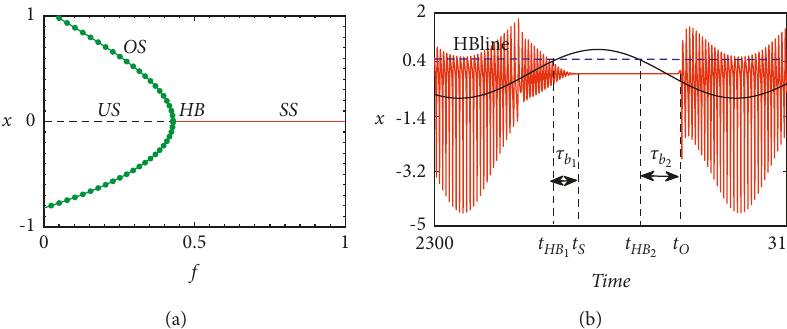
Figure 5: (a) One-parameter bifurcation diagram as a function of amplitude of external forcing f . Green filled circles represent the stable oscillations. The dashed (black) and solid (red) lines denote the unstable and stable steady state, respectively. (b) Time series signal t overlapped with the function f . Other parameter values are fixed same as in Figure 1. ( )